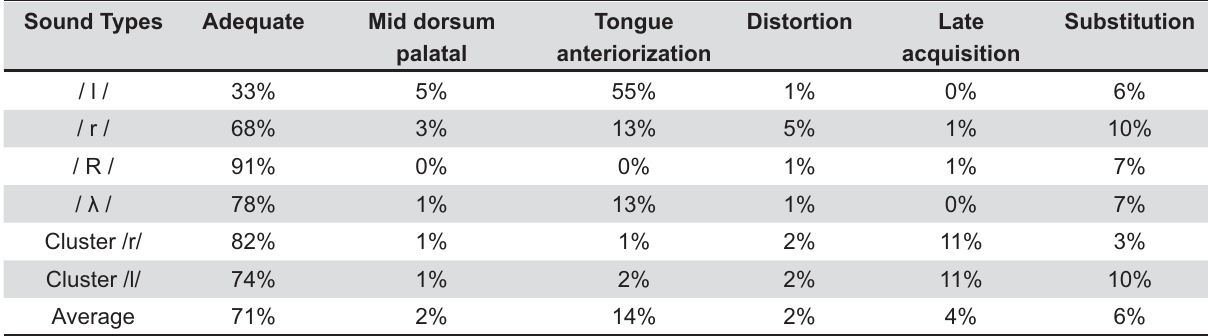
Table 1- Distribution of percentage occurrence of consonant production errors during liquid